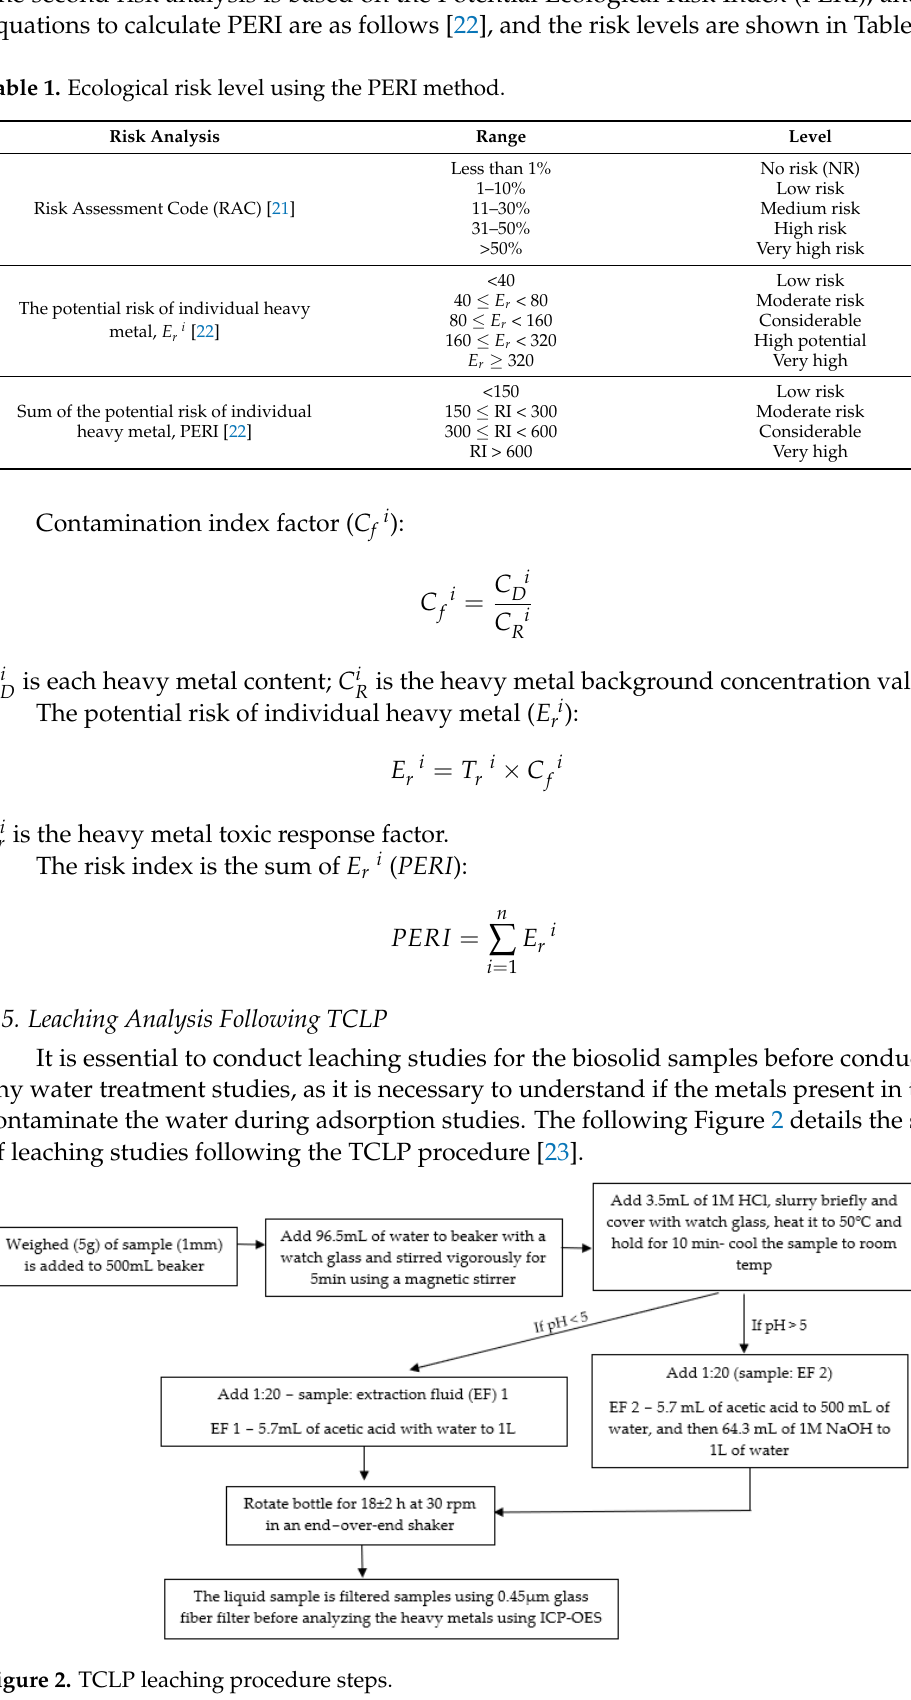
Figure 2. TCLP leaching procedure steps.